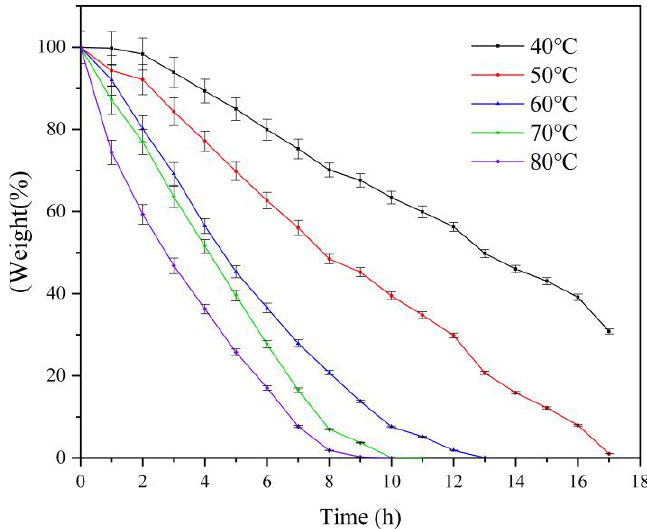
Figure 7. Water retention of SW-AA-AM polymer.